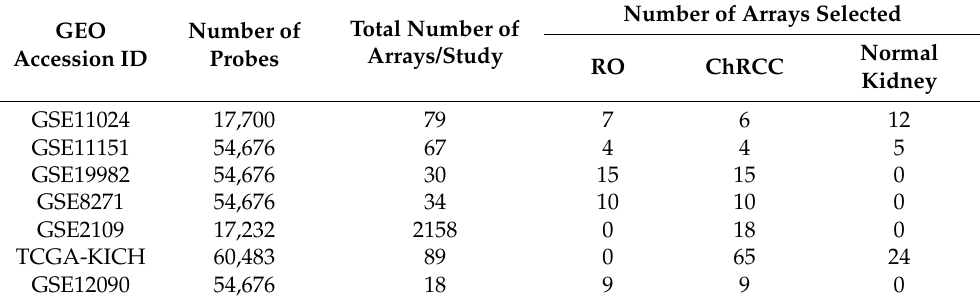
Table 1. GEO datasets selected for chromophobe renal cell carcinoma (chRCC) and renal oncocytoma (RO) classification as discovery and validation datasets. Table contains details on number of probes, total number of arrays in the study and number of arrays selected under chRCC, RO and normal kidney tissue.